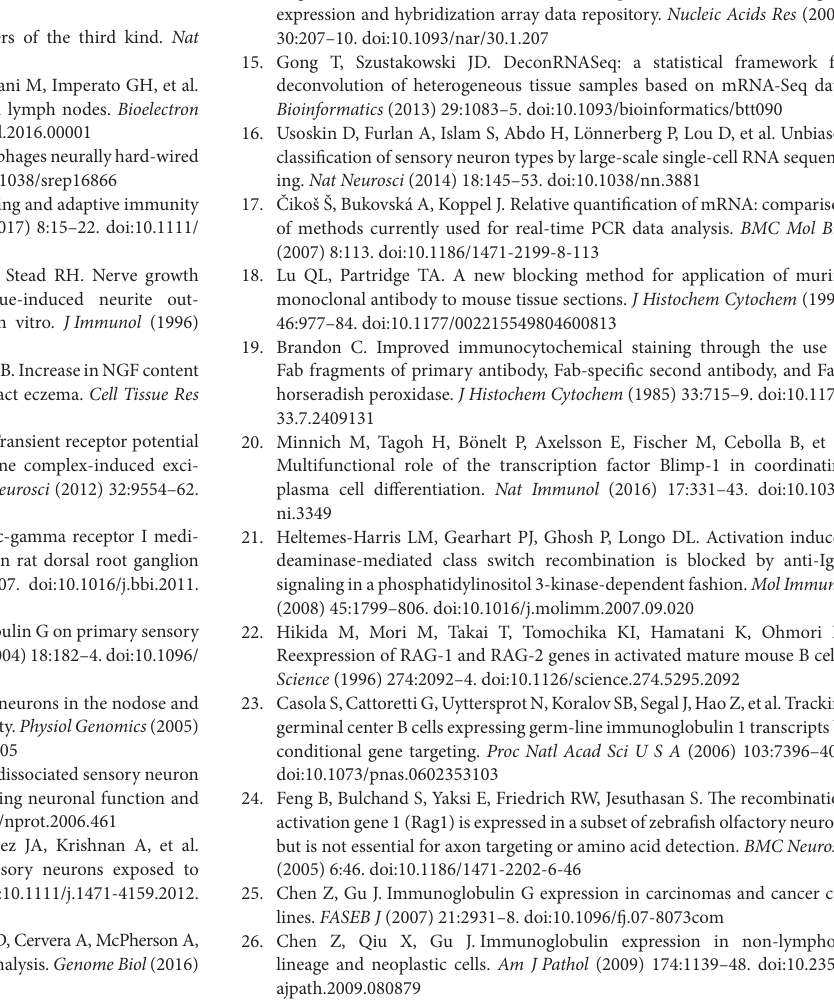
FigUre s1 | Cellular composition of DRG neuron preparations. The principal DRG cell types in the sensory neuron preparations isolated from DRGs collected from alum-injected and alum + KLH-immunized mice include neuronal cells: peptidergic nociceptor (PEP) cells, non-peptidergic nociceptor (NP) cells, and neurofilament containing (NF) cells, and non-neuronal (NoN) cells. The cell types were defined by Usoskin and colleagues (16), and the relative proportions were computed using RNA-seq deconvolution analyses, as described in the Section “Materials and